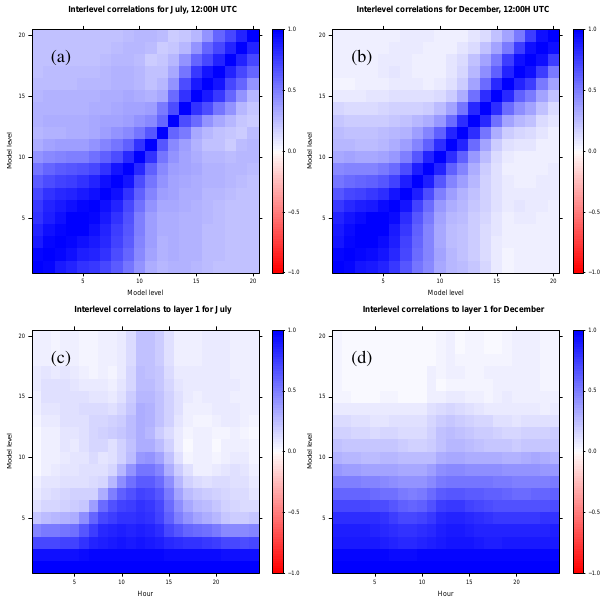
Fig. 4. Correlations between model variables with zero separation Fig.4. Correlationsbetweenmodelvariableswithzeroseparationdistance, r l,l 0 ; m,h ,atdifferentverticallayers distance, r l,l 0 ; m,h , at different vertical layers (upper row), and diur- (upperrow),anddiurnalvariationincorrelationbetweenlevel1andotherlevels(lowerrow). Theleftandright columnspresentresultsforJulyandDecember,respectively. nal variation in correlation between level 1 and other levels (lower row). The left and right columns present results for July and De- cember,